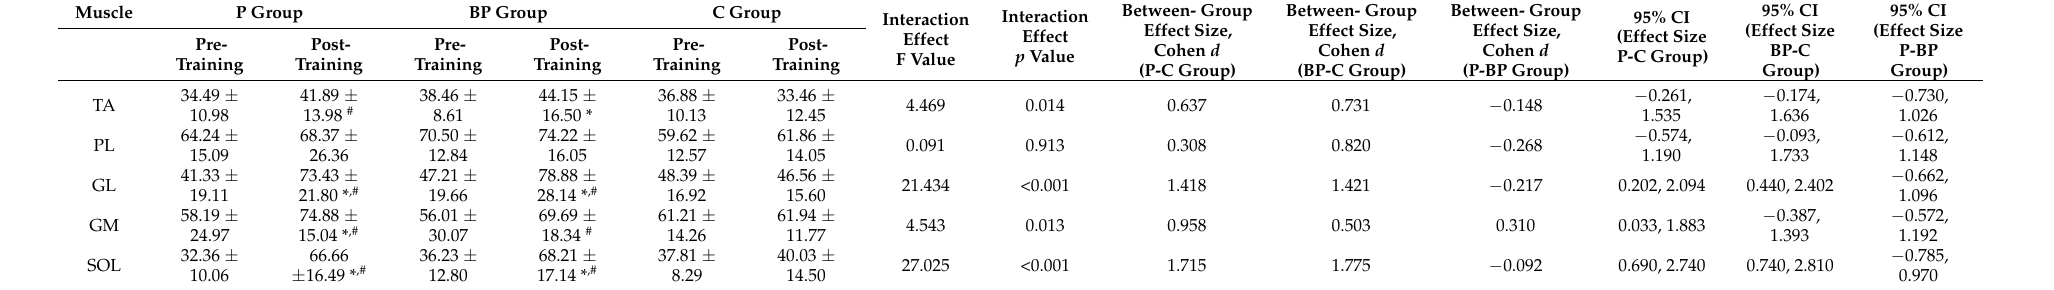
Table 2. Integrated EMG values of each group during pre-landing phase of medial drop-landing task (unit: % • ms).